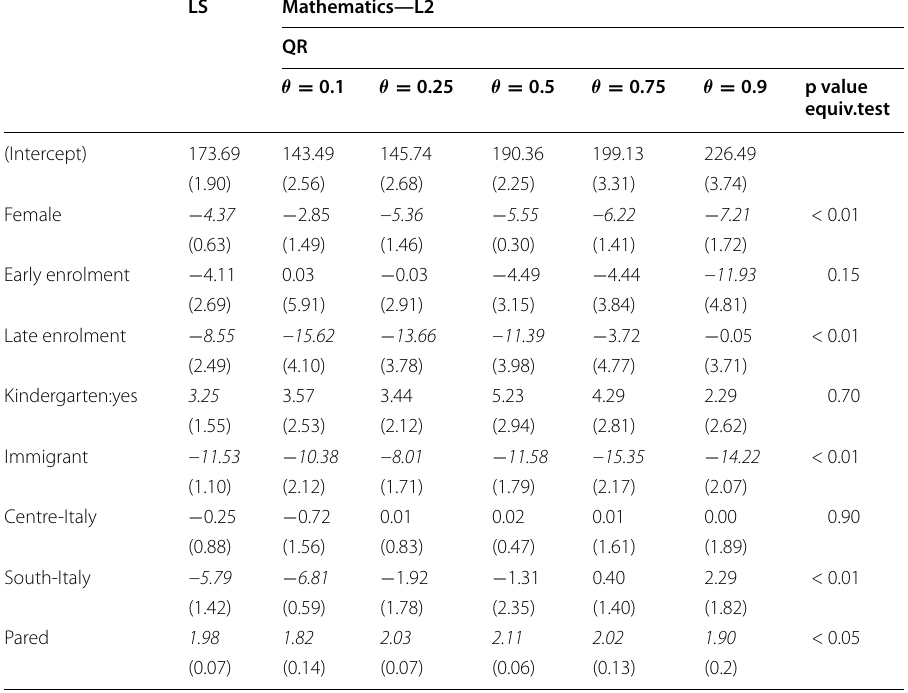
In Italic estimates with p < 0.05. Standard errors in parenthesis computed with non-clustered bootstrap estimation. In the last column the p value of the equivalence test (equiv.test)